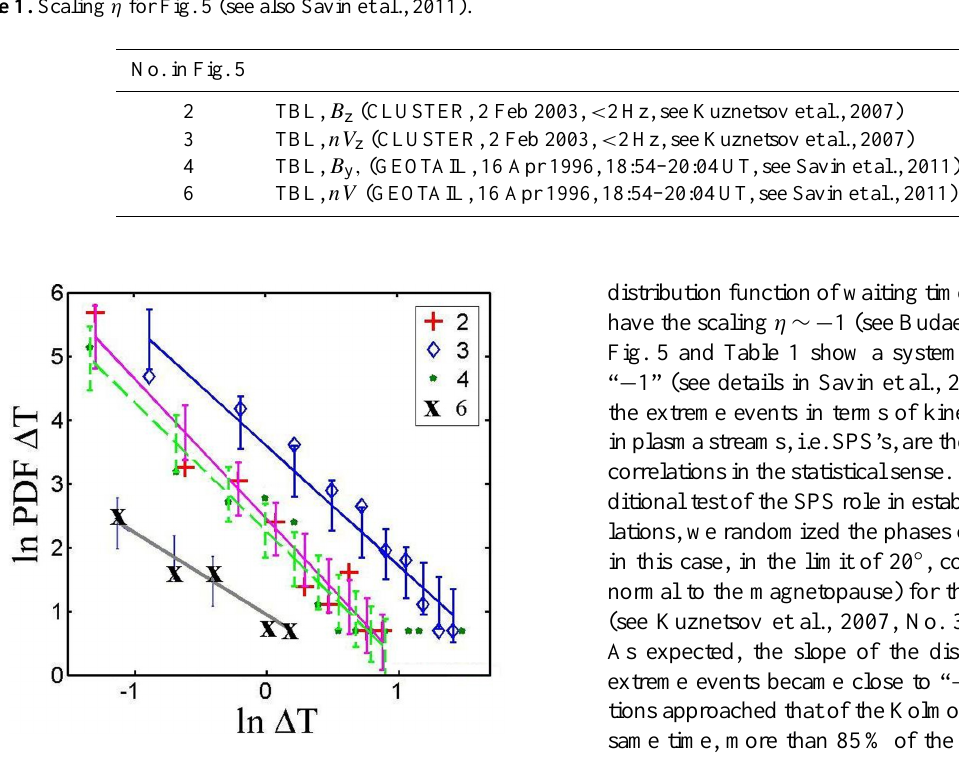
Fig. 5. The distribution functions of waiting times for extreme events (peaks above 2 standard deviations) in logarithmic scale. Numbers in the upper right corner correspond to Table 1. The data are approximated by P(t) ∼ t η (the “scaling” corresponds to the straight lines – see details in Savin et al.,